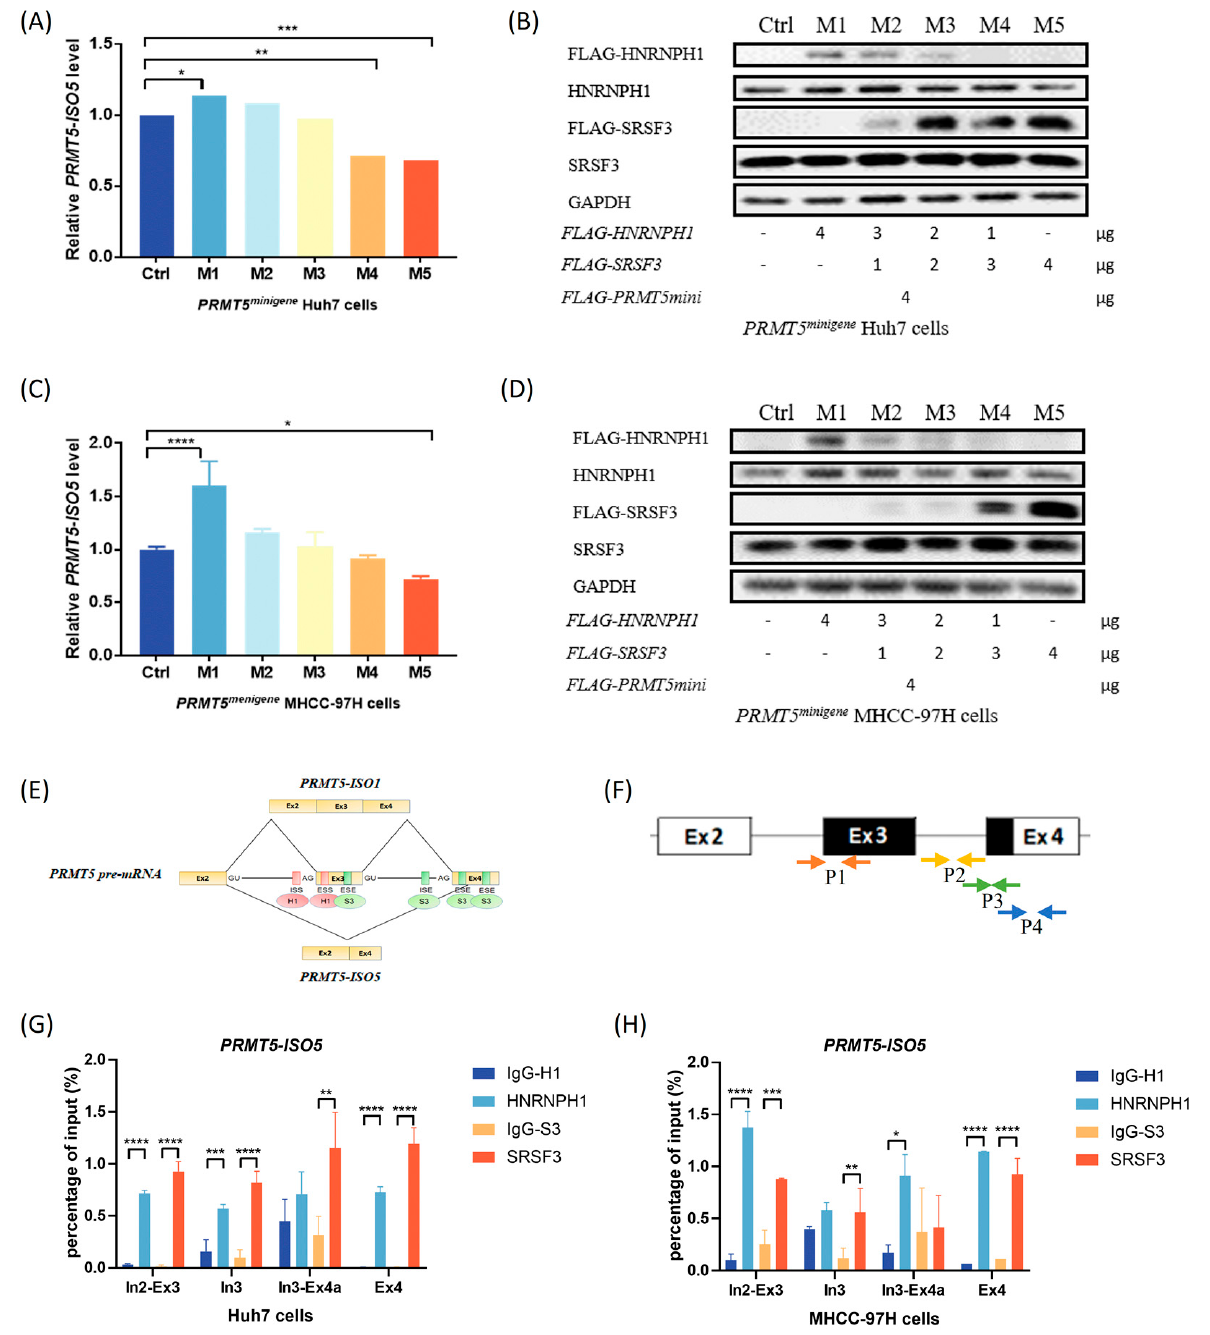
Figure 4. SRSF3 and HNRNPH1 competitively bind to PRMT5 pre-mRNA and regulate PRMT5 splicing. ( A ) The transcriptional level of PRMT5-ISO5 in Huh7 cells post-treatment. ( B ) The endo- and exogenous expression level of HNRNPH1 and SRSF3 in Huh7 cells post-treatment. Ctrl: transfected with 4 μ g pcDNA3.1- FLAG vector; M1-5: cells transfected with 4, 3, 2, 1, 0 μ g pcDNA3.1- FLAG-HNRNPH1 mixed with 0, 1, 2, 3, 4 μ g pcDNA3.1- FLAG - SRSF3 . FLAG-HNRNPH1 and FLAG- SRSF3 fusion proteins (exogenous expression) were detected with anti-FLAG, while HNRNPH1,